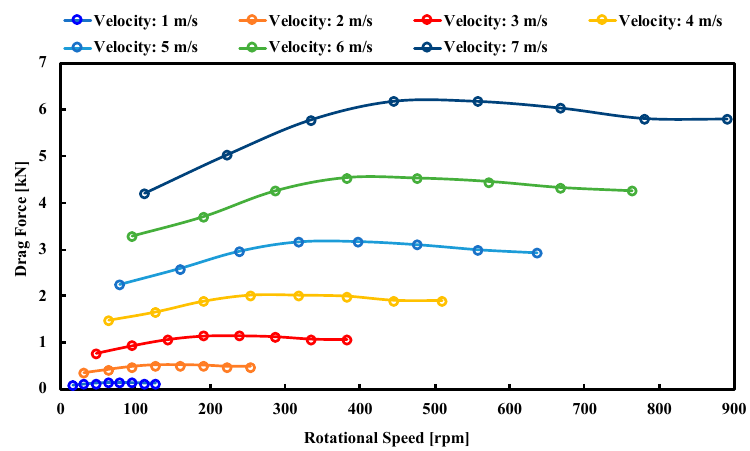
Figure 15. Power at different rotational speed.